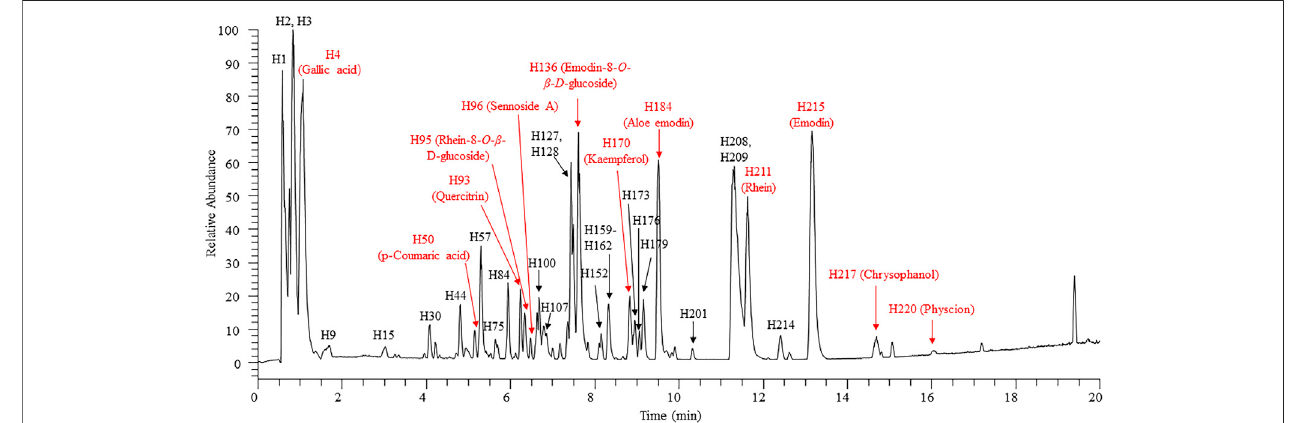
FIGURE 1 | High-resolution total ion chromatogram of rhubarb. Red: compounds veri fi ed by reference substances.